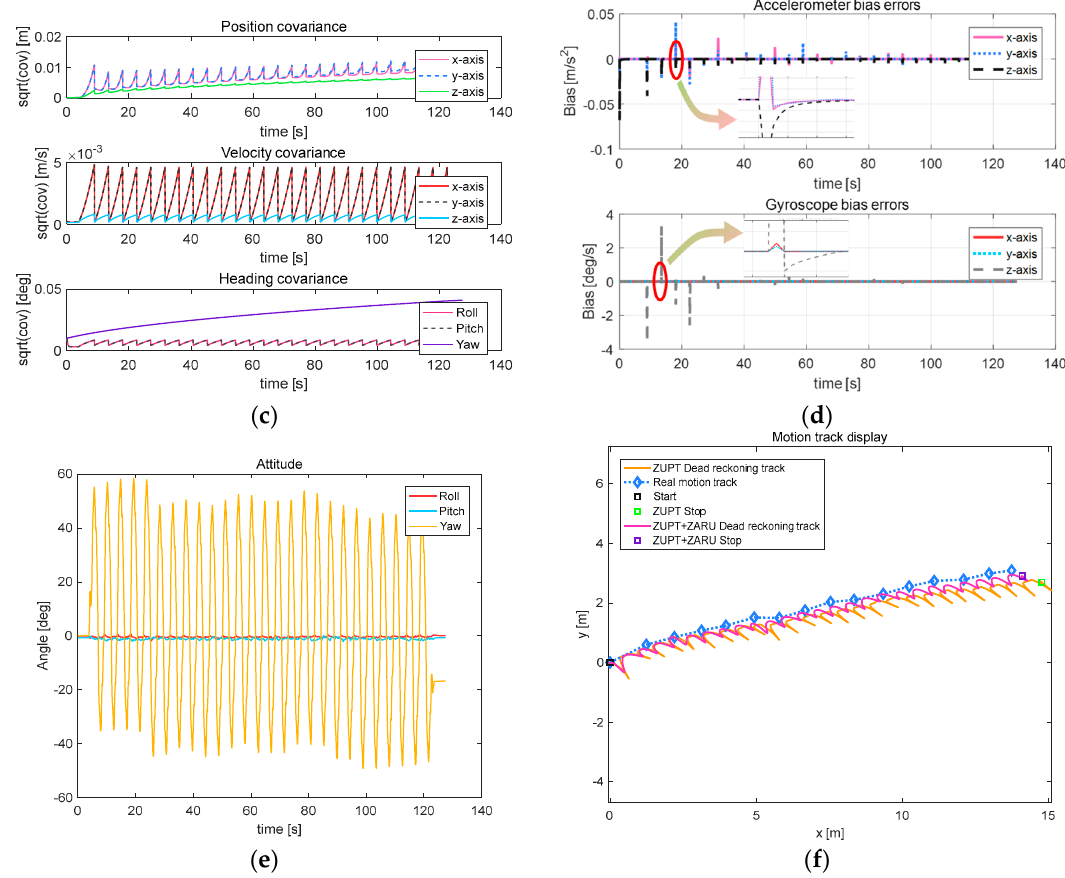
Figure 14. Parameters related to linear motion under velocity and angular velocity constraints.